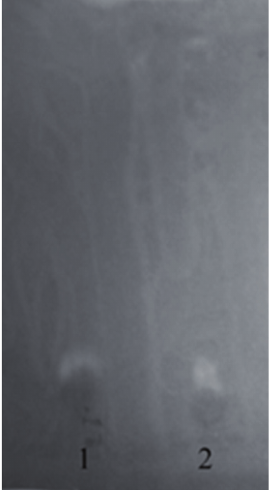
F 11: Effect of inhibitors on F. solani PHB depolymerase. N-acetylimidazole. Phenylmethylsulfonyl �uoride (PMSF) is